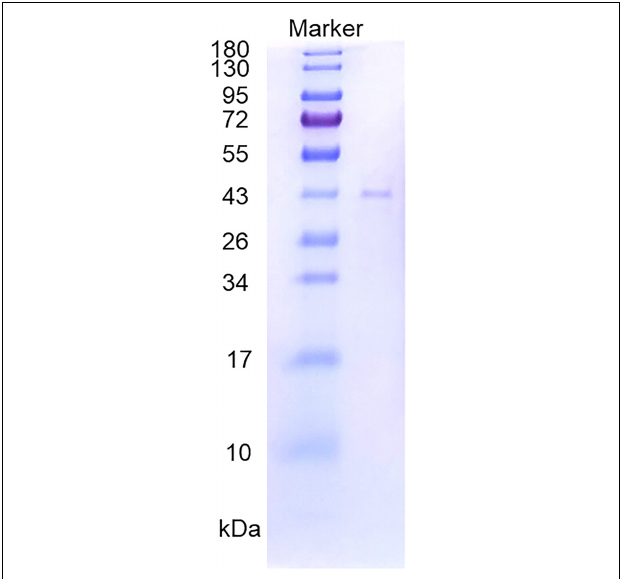
FIGURE 3 | HPSEC-RID chromatograms of degradation products of Cgbk16A_Wf were examined by using the TSKgel SuperAW4000